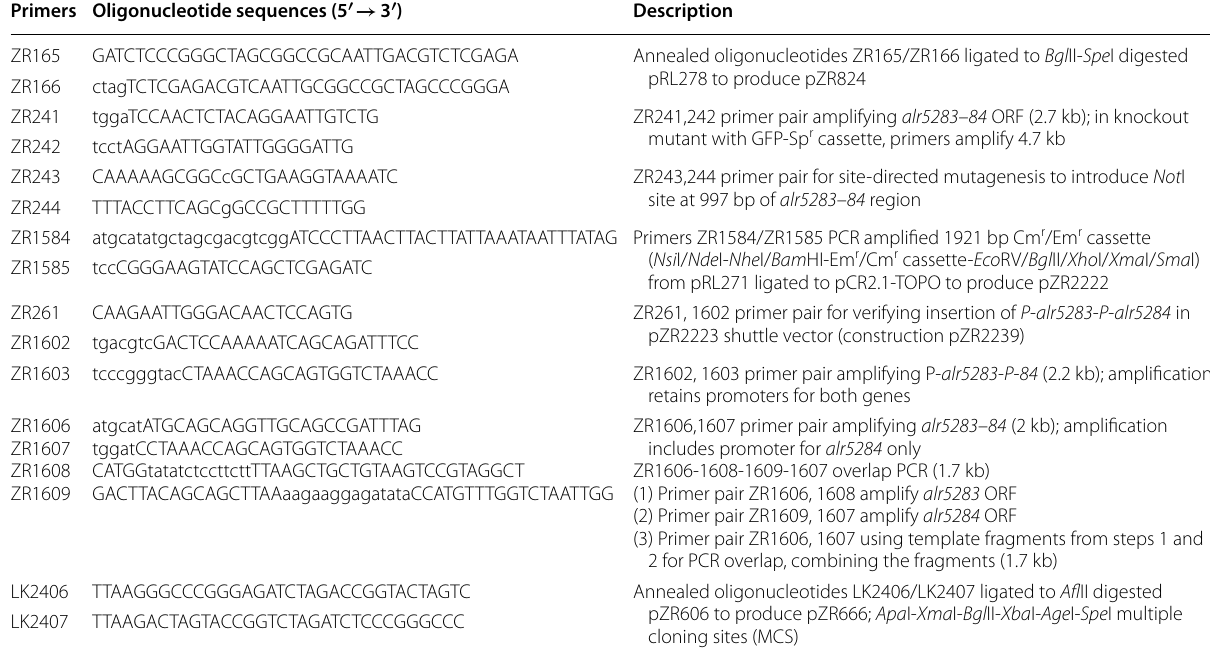
Sp: spectinomycin resistance; ORF: open reading frame; GFP: green fluorescent protein; MCS: multiple cloning sites, RBS: ribosome-binding site, P-: promoter, PCR: polymerase chain reaction